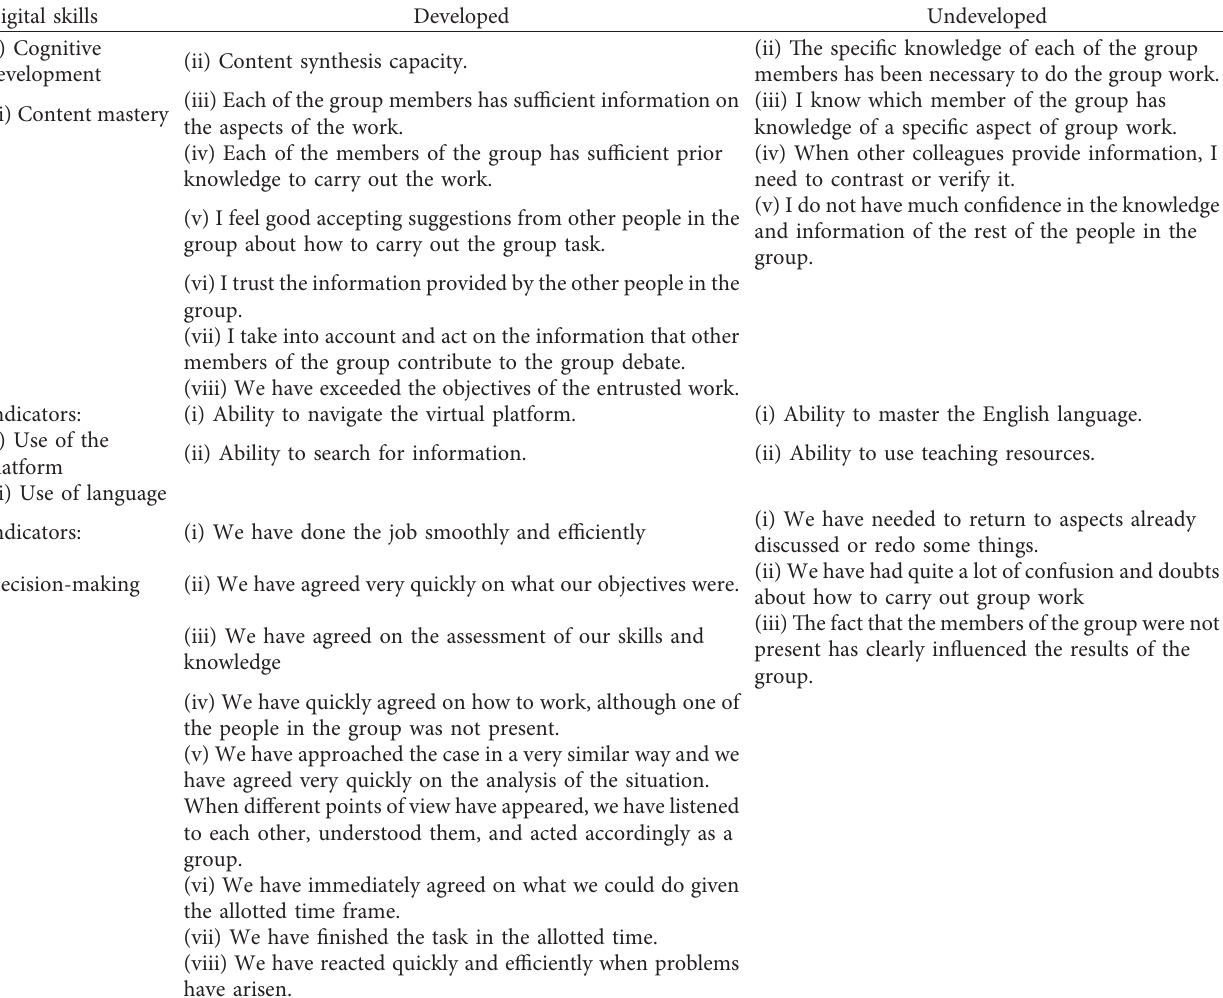
Table 4: Structure of the working groups.